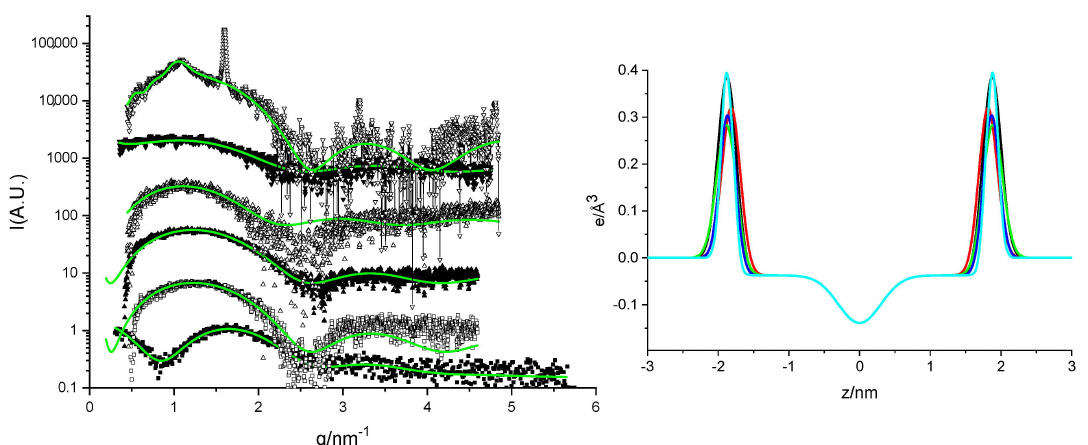
Figure 6. Left: SAXS spectra of DMHNHC 14 (squares) and increasing contents of Myristate from bottom to top 80:20 HM, 60:40 HM, 50:50 HM, 40:60 HM and 20:80 HM. Fitting curves of lamellar models for the mixtures and core-shell spherical poly-disperse micelles for pure DMHNHC 14 at 25 ◦ C. The curves have been scaled by factors of five with the original intensity for the bottom one. Right: Electron density profiles of the mixtures as obtained from the fitting of the lamellar model on the SAXS spectra at 25 ◦ C, lines in black 80:20 HM, red 60:40 HM, green 50:50 HM, blue 40:60 HM and light blue 20:80 HM. See the Methods Section for details of the